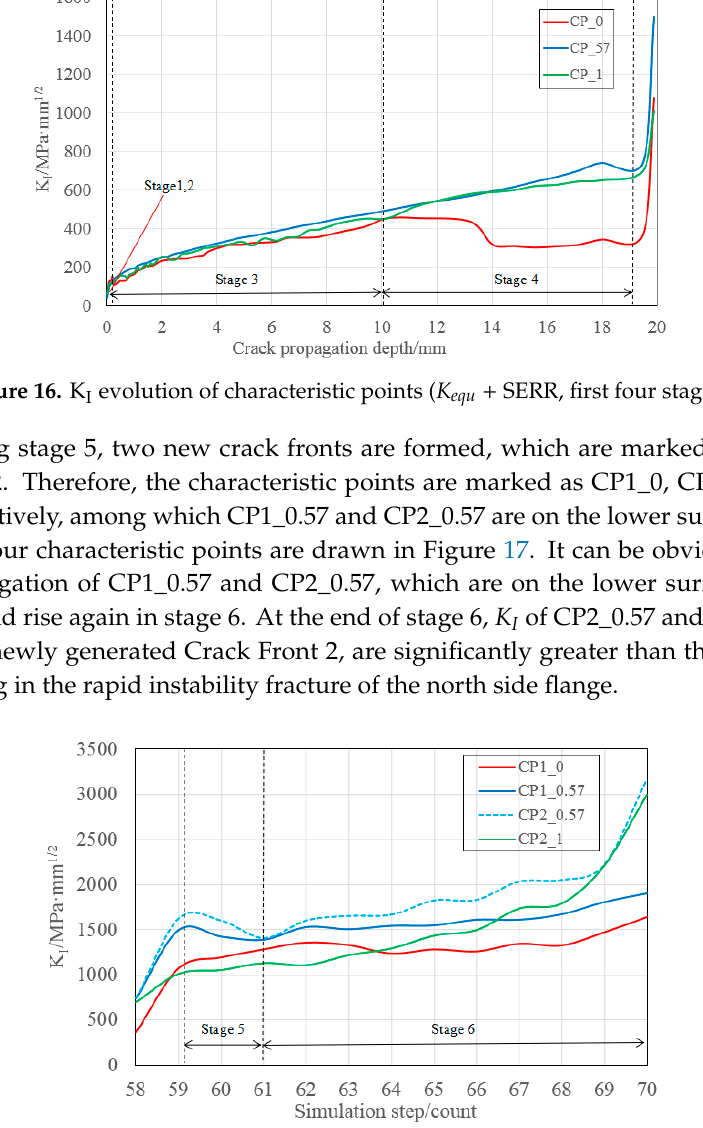
Figure 17. K I Evolution of characteristic points ( K equ + SERR, stage 5 and 6).